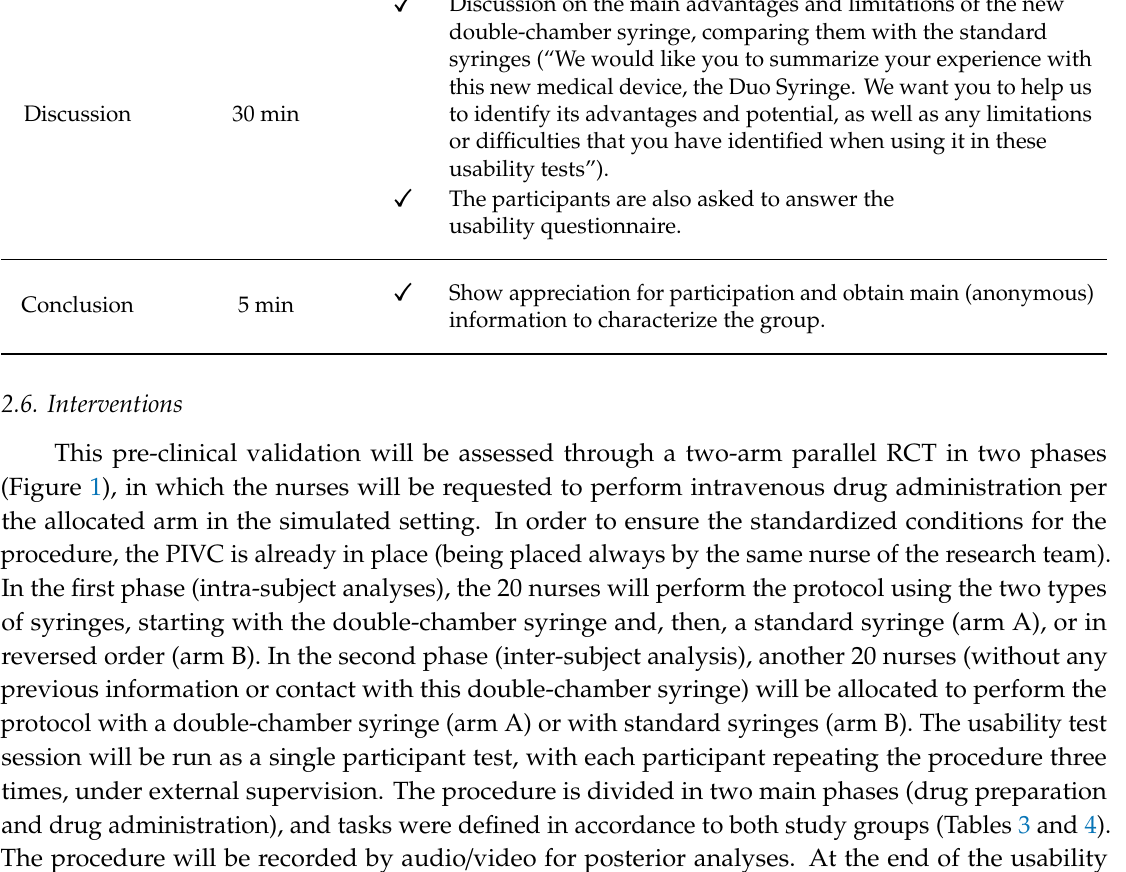
catheter (PIVC) to simulate intravenous drug administration and flushing.